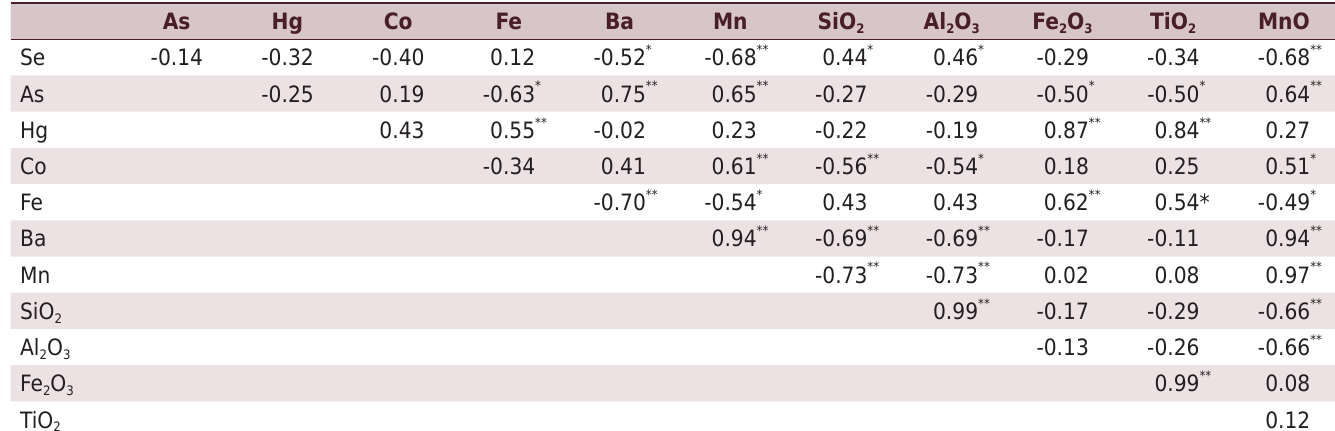
Table 3. Pearson’s correlation between total contents of potentially toxic elements and oxides of soil and sediments from Serra Pelada